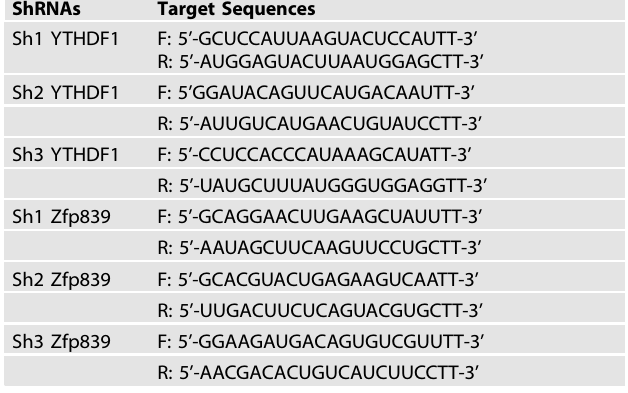
Table 1. shRNAs for YTHDF1 and